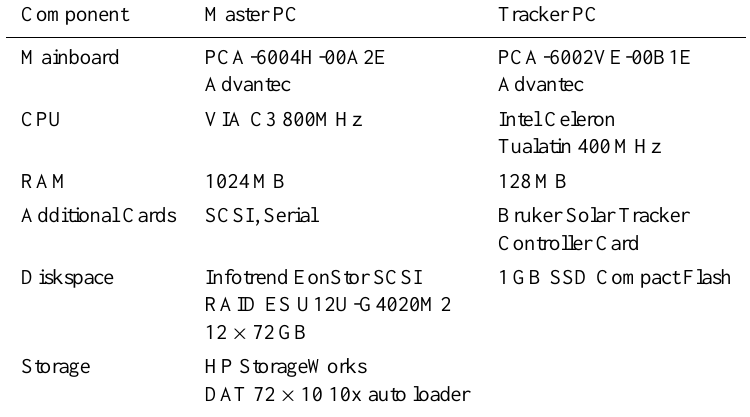
Table 2. Dual PC